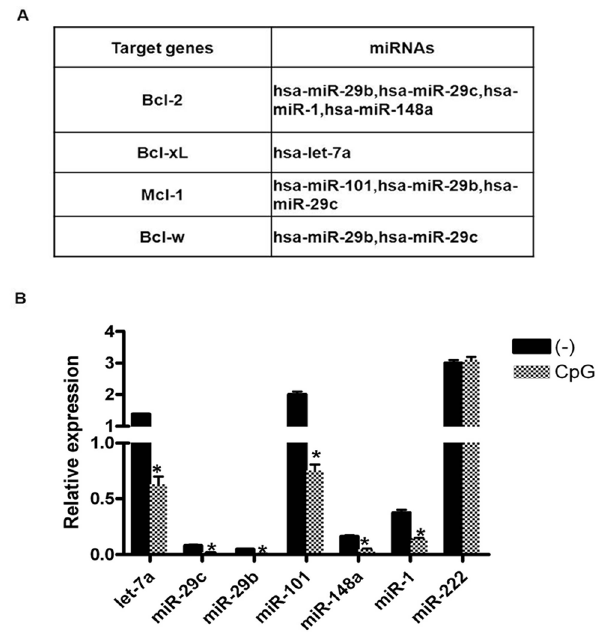
Figure 2. miRNAs predicted to target Bcl-2 family members. The miRNAs presented in Figure 1 were analyzed using bioinformatics. (A) miRNAs predicted to target Bcl-2 family members. (B) miRNA expression changes upon CpG stimulation. After 6 hours of CpG stimulation, pDC miRNAs were extracted and analyzed using a TaqMan MicroRNA Expression Assay. Expression levels were normalized to RNU48. The data are representative of at least 3 independent experiments, each using a different pDC preparation. Data are expressed as the mean 6 SD and were analyzed with a 2-tailed Student’s t test. *P , 0.05.